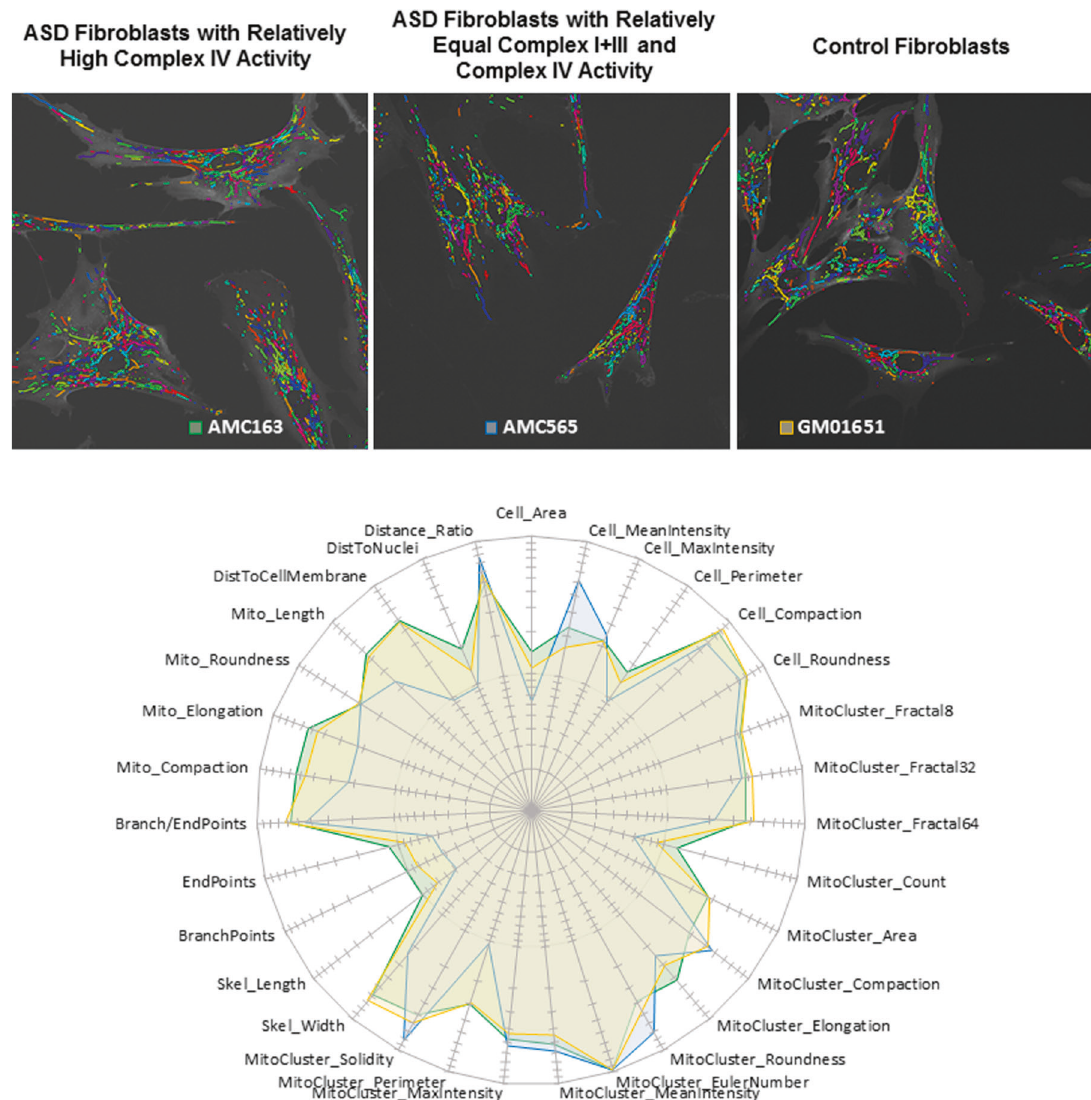
Fig. 5 Radar-chart distribution of normalized morphological features obtained for representative fi broblasts from patients with autism spectrum disorder or from control individuals. Three representative microscopic fi elds are shown that correspond to control fi broblasts (GM01651), ASD fi broblasts with elevated Complex IV activity relative to Complex I + III (AMC163) and ASD fi broblasts with relatively equal Complex IV and I + III activities (AMC565). The segmented images (top panels) were randomly colorized for illustrative purposes. Parameter values V p (expressed as arbitrary units) were obtained using the MITOTOUCH ® software. Minimum value (Vmin) and maximum value (Vmax) were derived for each parameter based on the entire data set. Values V p were normalized (to give V n ) by applying the following formula: V n = ( V p – V min )/( V max – V min ) and V n values were reported on the radar chart (bottom panel). Fibroblasts with relatively increased Complex IV activity (green line) have their morphological feature space more similar to that of control fi broblasts (orange) (for 29 parameters out of 31) whereas the morphological feature space of fi broblasts with relatively equal ETC Complex I + III and IV activities (blue) appear to be slightly samples had enzyme activity outside of the normal range [26, 27]. Supportive of a high prevalence of abnormal mitochondrial enzyme activity is the fact that biomarkers of mitochondrial dysfunction are also reported to be abnormal in 8 – 47% of individuals with ASD [24, 68]. The discrepancy between the prevalence of classic mitochon- drial disease and physiological measurement of mitochondrial dysfunction can be explained by the fi ndings of atypical (i.e., different from classical mitochondrial disease) mitochondrial dysfunction in individuals with ASD. Several variations of unique